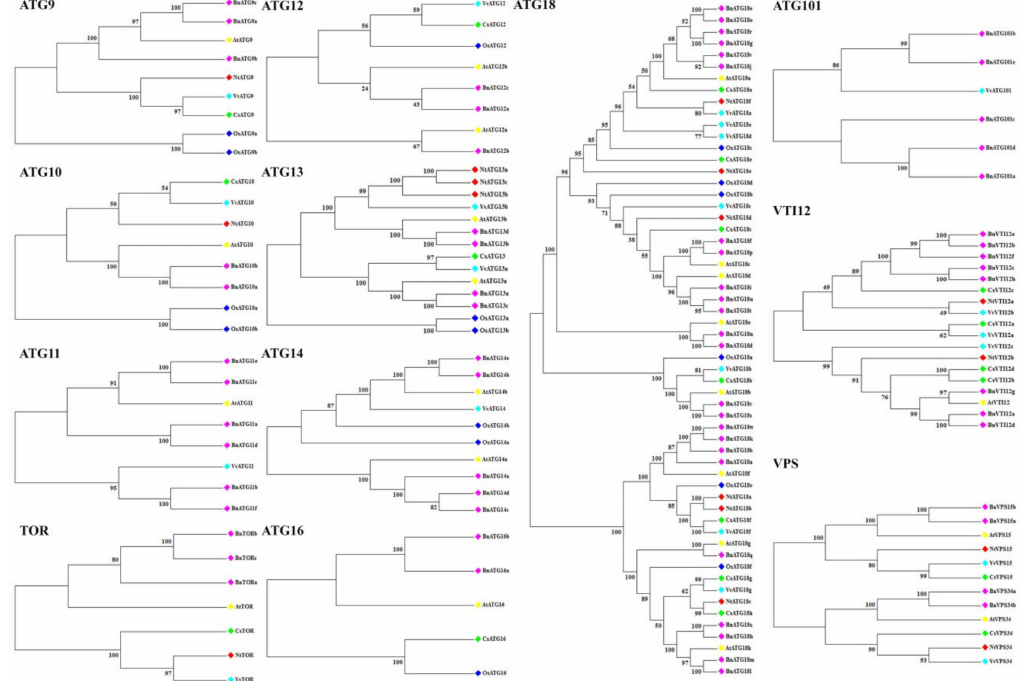
Figure 2. Phylogenetic relationships of BnATG9-BnATG114, BnATG16, BnATG18, BnVTI12, BnTOR, BnVPs15, BnVPS334, and BnVTI12 from Brassica napus (Bn), Arabidopsis thaliana (At), Citrus sinensis (Cs), Oryza sativa (Os), Vitis vinifera (Vv), and Nicotiana tabacum (Nt). The tree was constructed using MEGA 7 by the neighbor-joining (NJ) method with 1000 bootstraps. The names with pink rhombus are B. napus